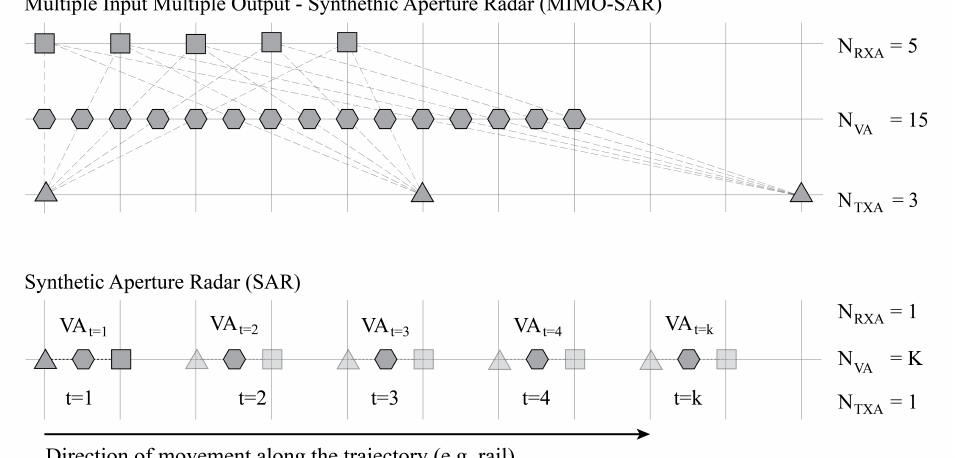
Figure 1. Schematic of MIMO-SAR (top) and classical SAR (bottom) showing the positions of virtual antennas (hexagon) derived form the positions of transmitting (triangle) and receiving (square) antenna